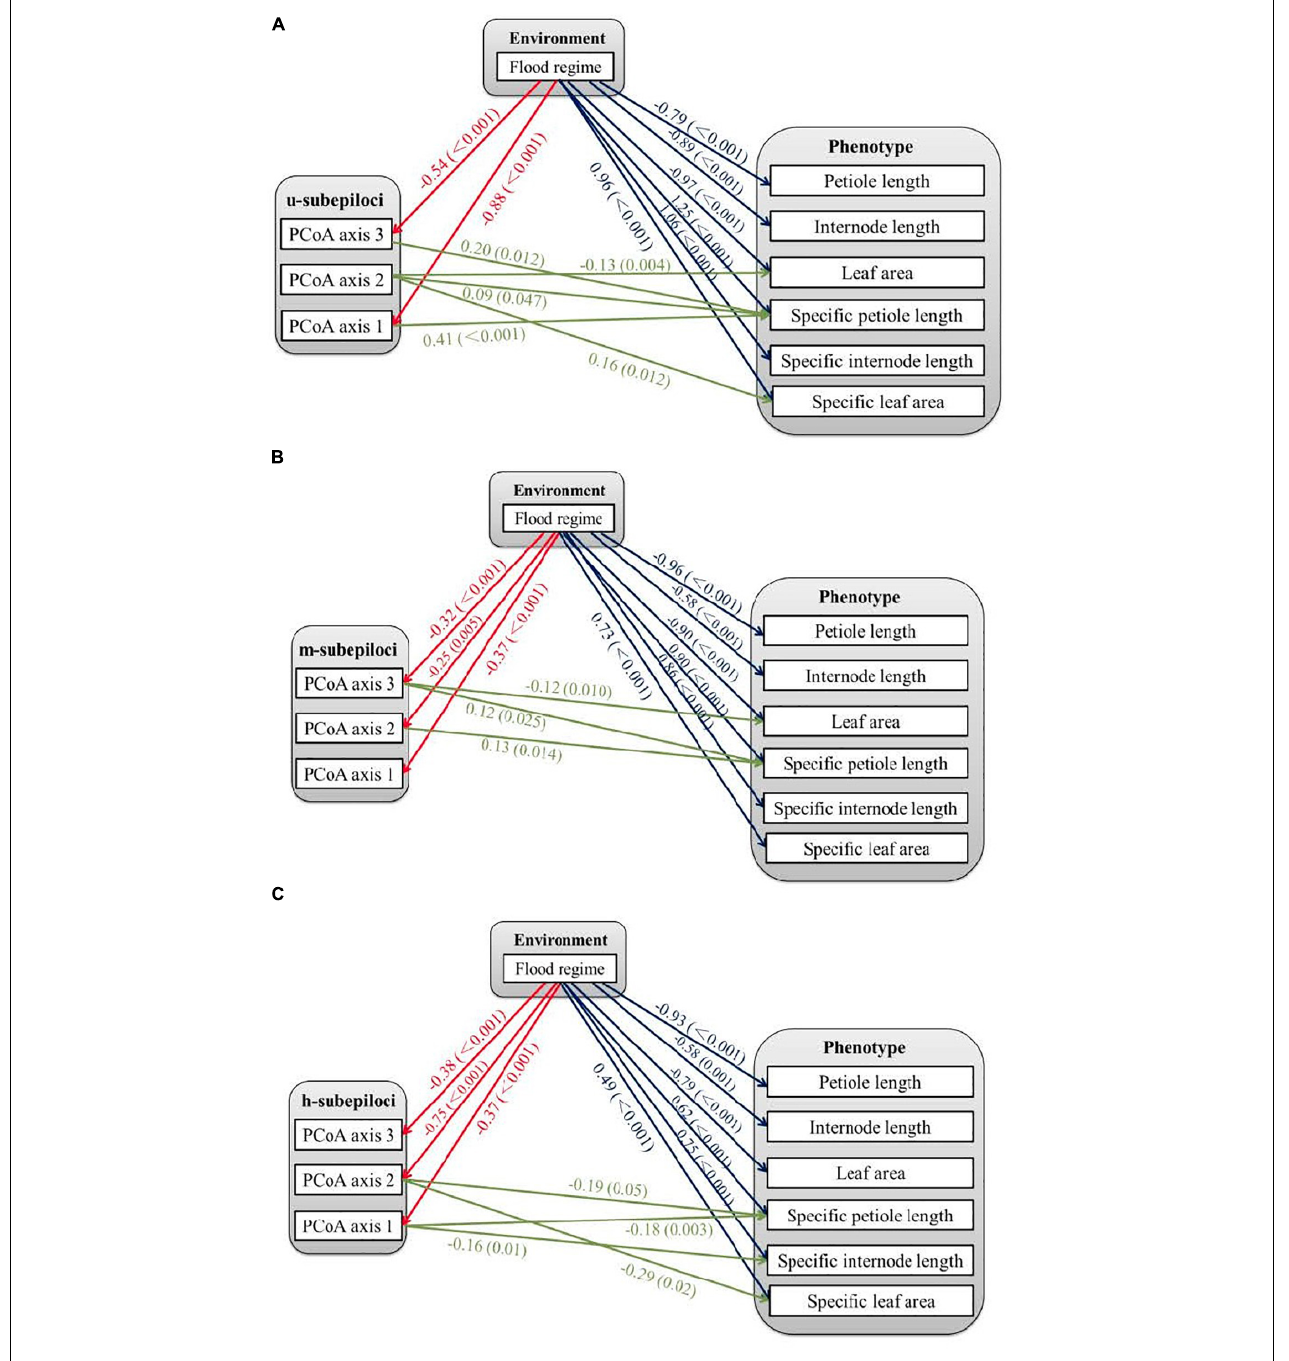
FIGURE 4 | Relationships among environmental, epigenetic and phenotypic variation of Hydrocotyle vulgaris . The epigenetic variables are the first three axes from principal coordinate analyses (PCoA) of different types of subepiloci, i.e., (A) u-subepiloci, (B) m-subepiloci, and (C) h-subepiloci. The lines with arrows indicate significant correlations between variables, with coefficients and P -values showing near the lines.